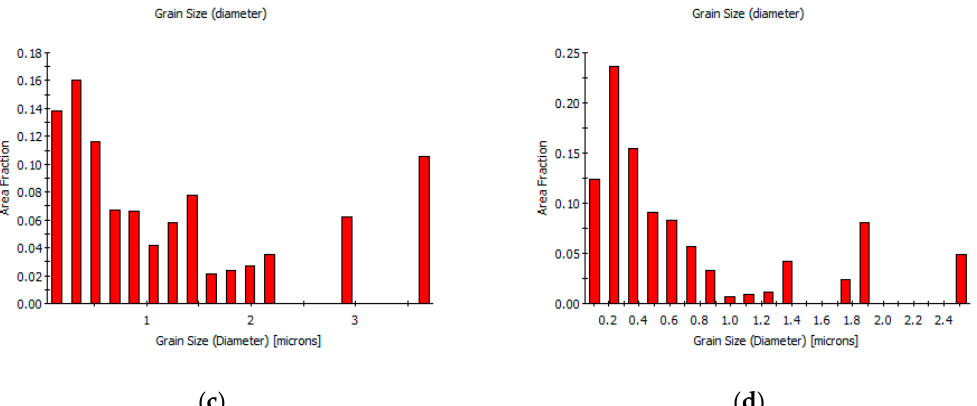
Figure 8. Differences in grain orientation and grain size of blanked edge under high speed blanking.